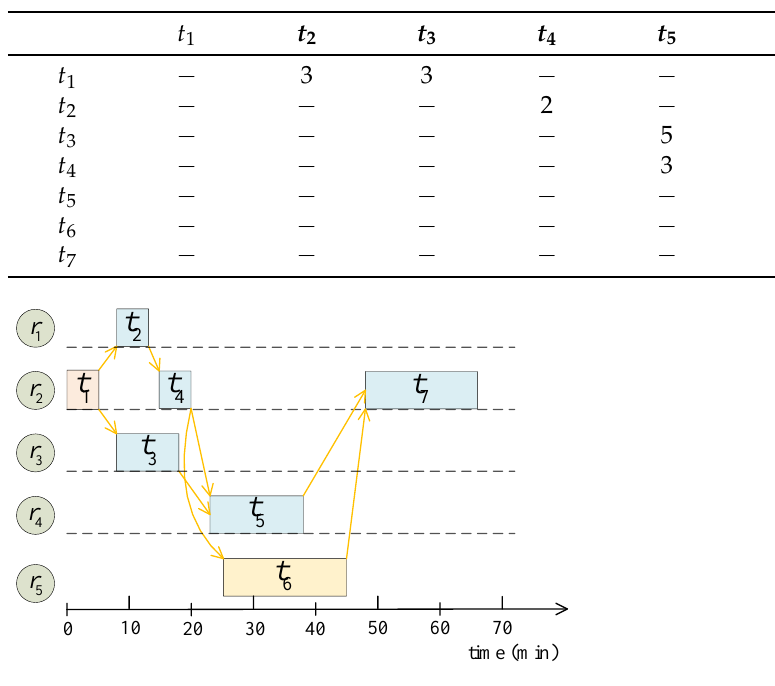
Table 2. Examples of data transmission time (in minutes) among tasks.